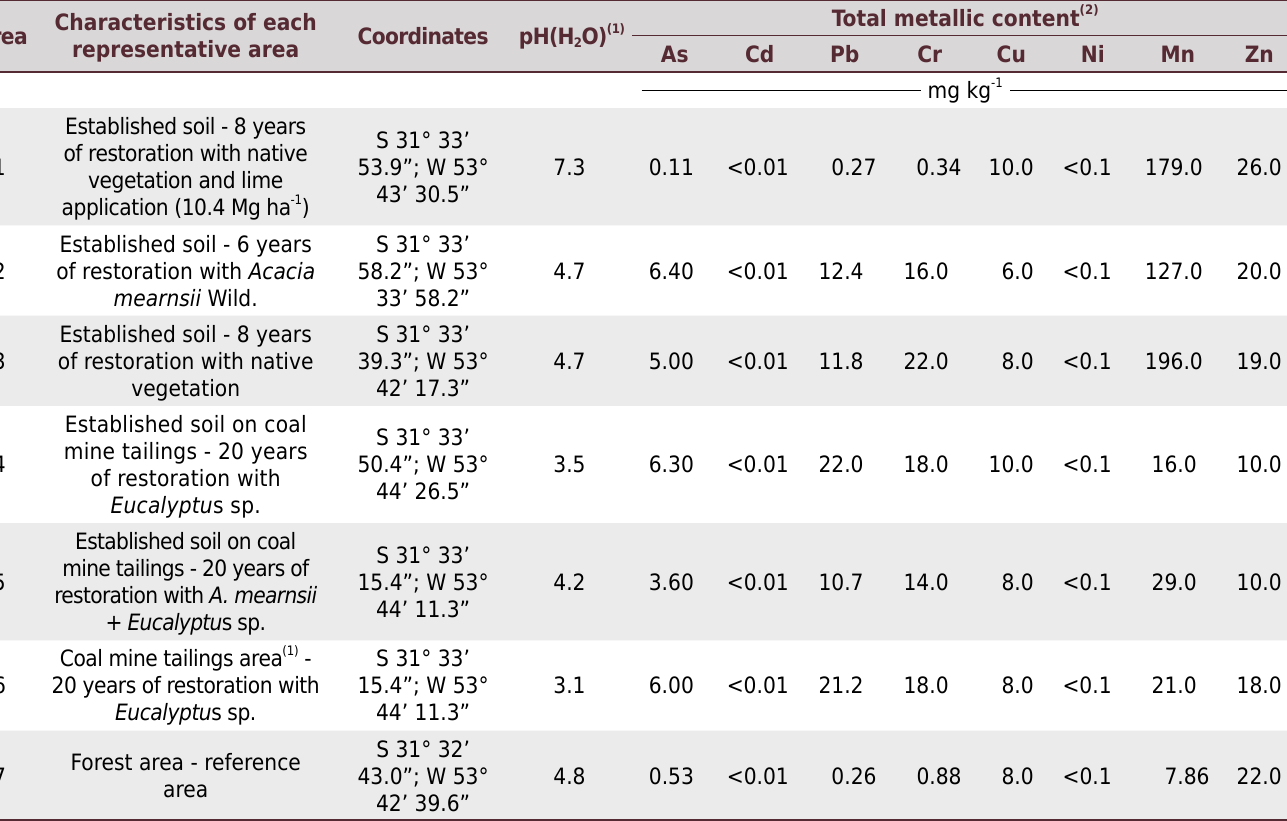
Table 1. Restoration history and soil chemical properties from the coalmine region of Candiota, RS-Brazil Characteristics of Area